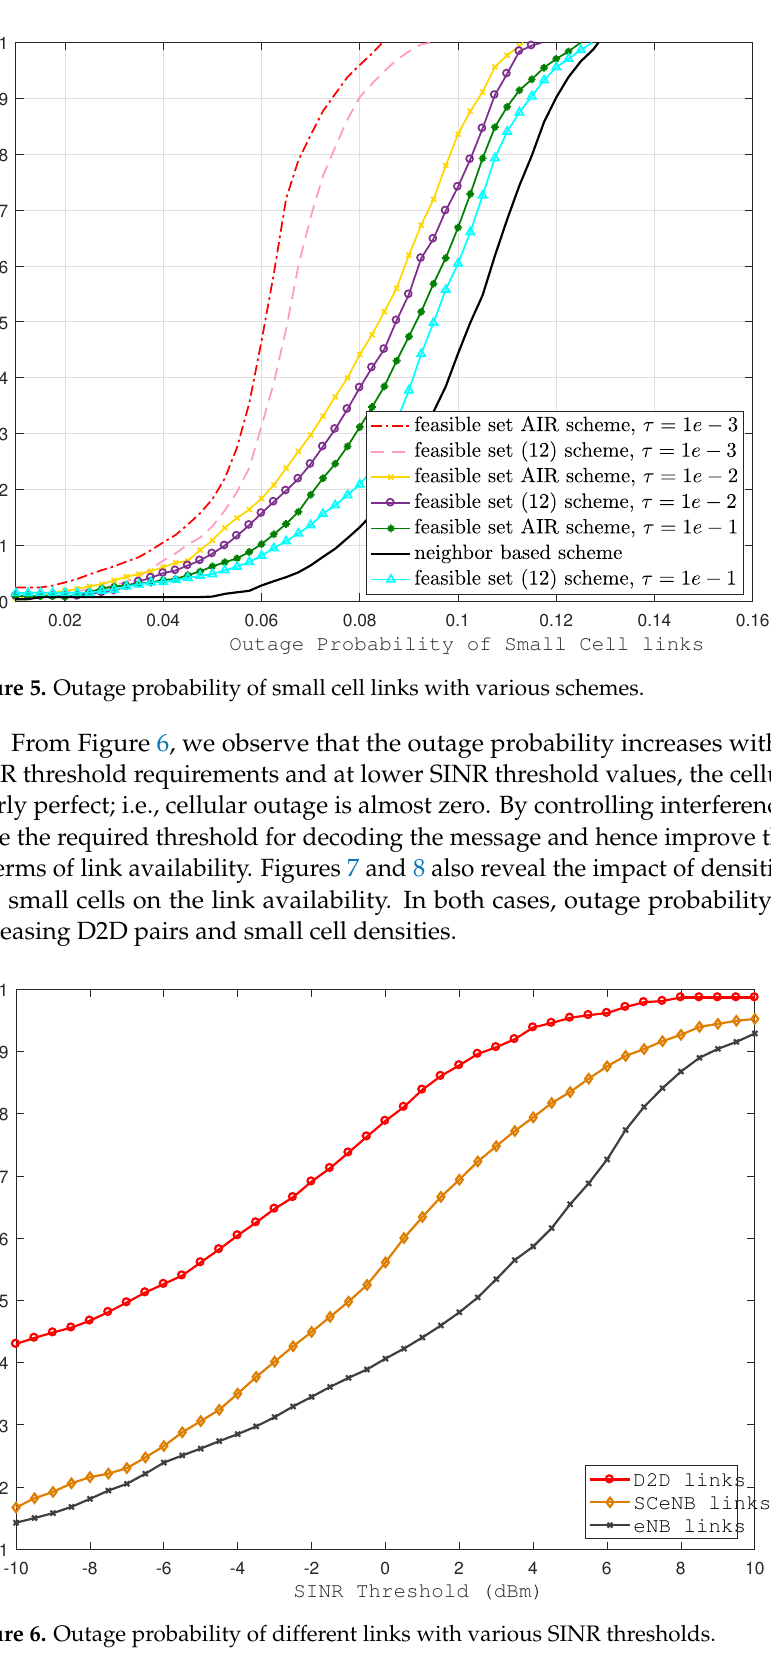
Figure 6. Outage probability of different links with various SINR